Question: Condense the content of this figure into a single sentence.
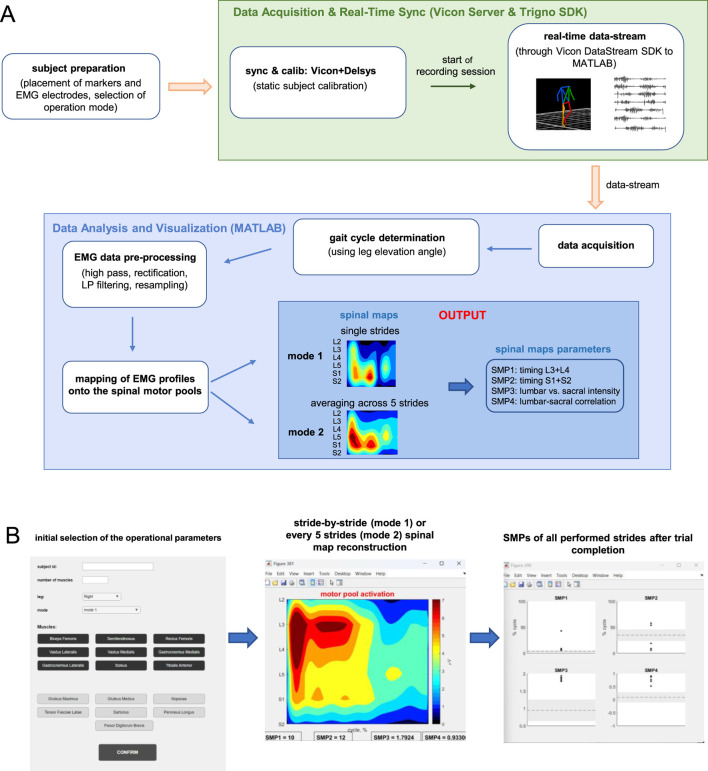
Answer: Flow diagram of the near real-time data processing pipeline and software user interface layout. (A) The steps in the flow diagram include real-time acquisition of kinematic and EMG data, gait cycle recognition, pre-processing of the data in Matlab, reconstruction of the spinal motor pool activation, and visualization of the spinal map and corresponding SMPs. (B) The graphical user interface windows demonstrate: the initial configuration of operational parameters and body-side target channels (left panel); the near real-time visualization of segment activation and running parameters rendered after cycle (mode 1) or five cycles (mode 2) termination (middle panel); and the aggregate plotting of accumulated metrics following trial completion (right panel), where individual circles denote separate strides and the underlying horizontal grey bands define the normative baseline (mean ± SD) calculated from reference TD children.